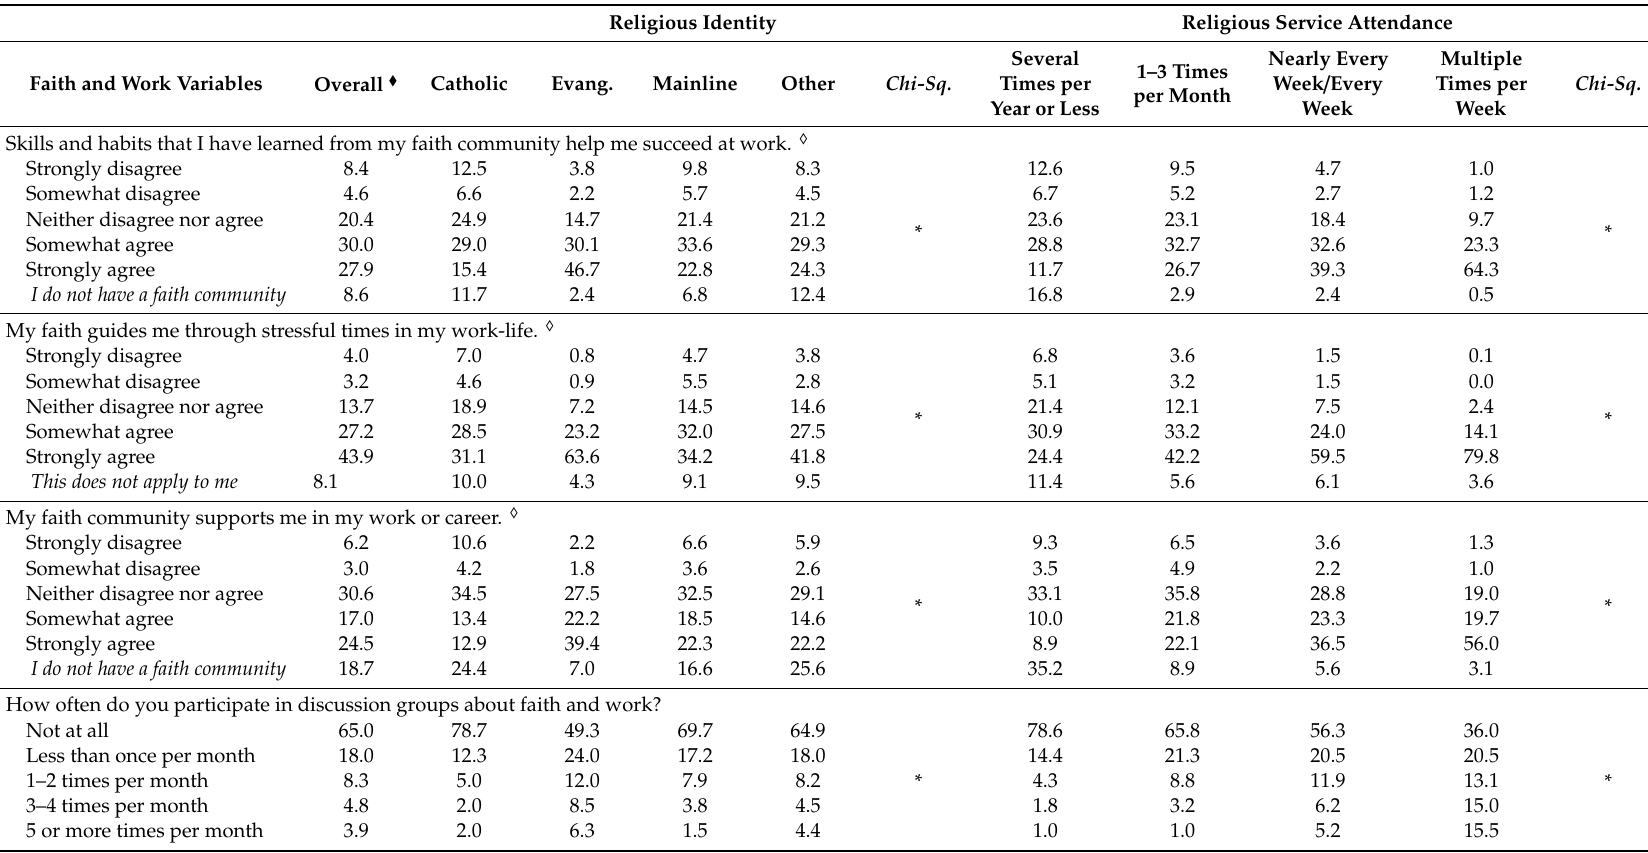
Table A1. Faith and Work Survey Questions by Religious Identity and Attendance among a Sample of Practicing Christians ( n =